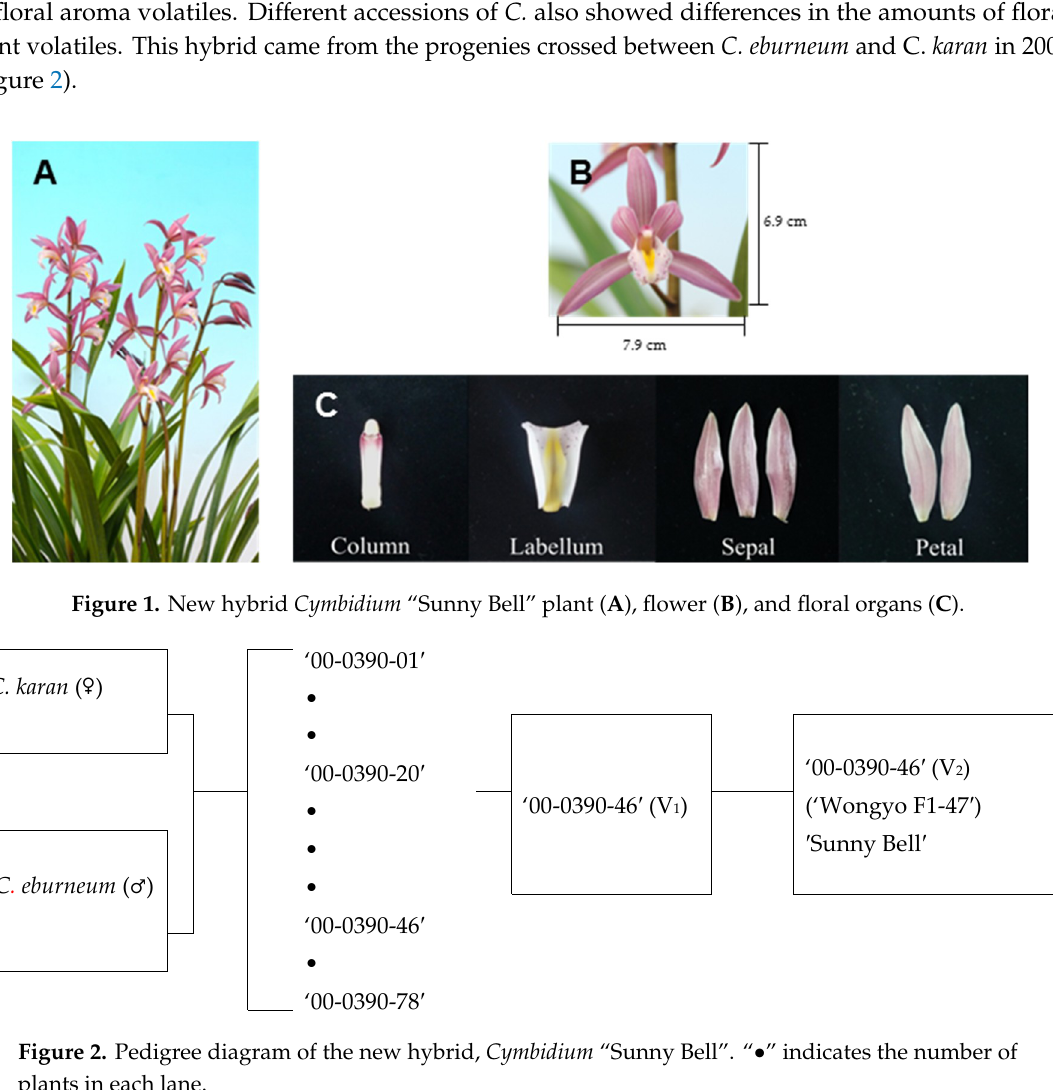
Figure 2. Pedigree diagram of the new hybrid, Cymbidium “Sunny Bell”. “•”indicates the number of plants in each lane.